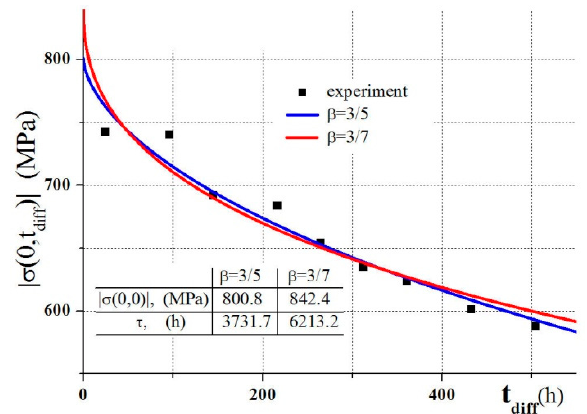
Figure 6. The exponents matched for the Equation (10) and the determined parameters for the model of short-range stress relaxation ( β = 3/5) and structural relaxation ( β = 3/7).